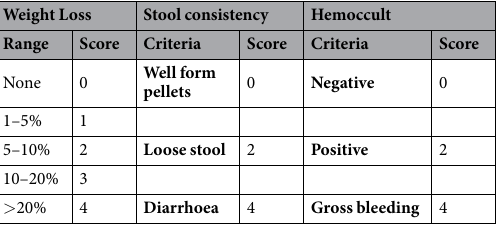
Table 1. The criteria for DAI scoring. The disease activity index (DAI) value is calculated ashe DAI value is calculated as the sum of the scores for weight loss, stool consistency, and blood in